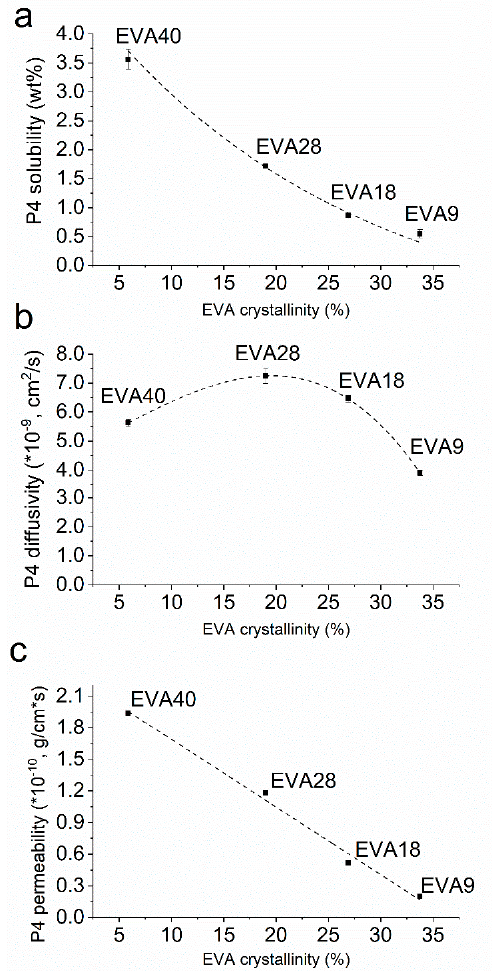
Figure 2. Progesterone (P4) solubility ( a ), diffusivity ( b ), and permeability ( c ) in ethylene-vinyl acetate (EVA) polymers at 37 °C as a function of the polymers’ crystallinity.